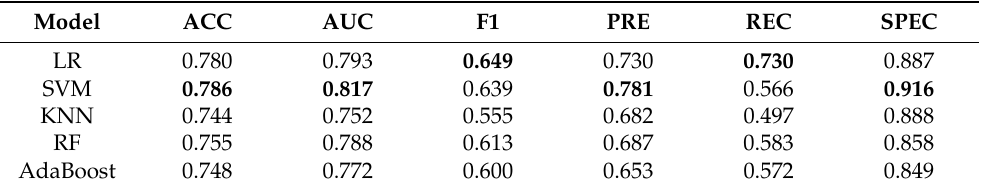
Table 8. Computational results for CGGA dataset with LASSO feature selection method and individ- ual models.